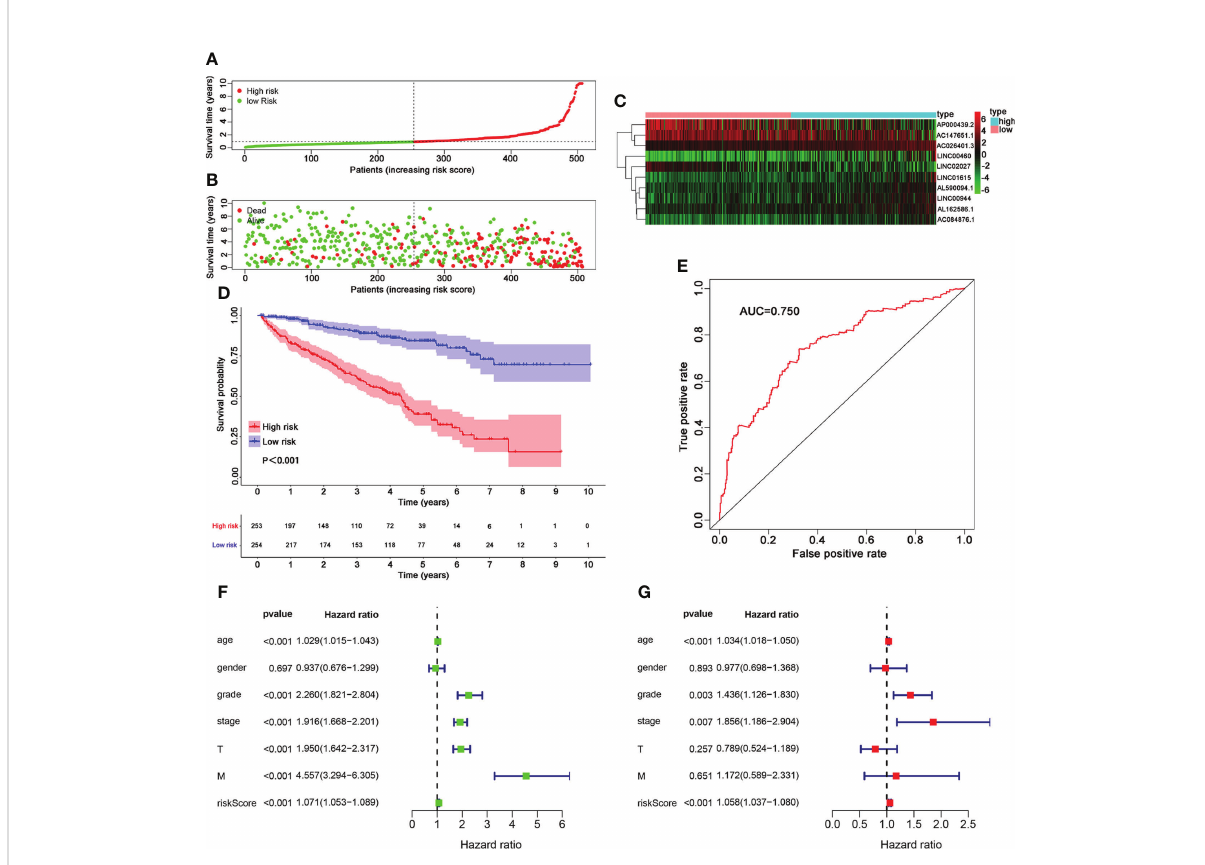
FIGURE 4 Analysis of TIL-related lncRNA signature for patients with ccRCC. (A – C) lncRNA predictor-score analysis of 507 ccRCC patients. The horizontal axis represents the 507 patients. Heat map of lncRNA expression level. (D) Survival time of patients between the groups. (E) Areas under the ROC curve. Forest plots for univariate (F) and multivariate (G) Cox regression